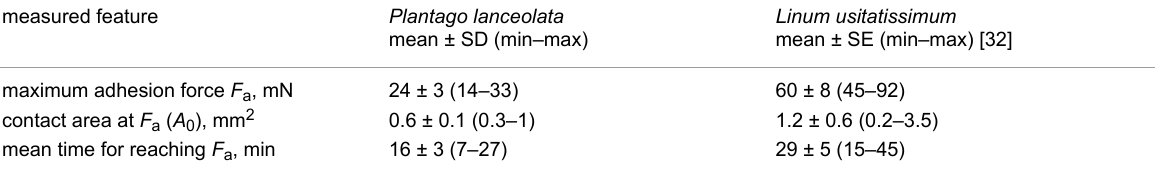
Table 3: Comparison of adhesion force data for Plantago lanceolata (cellulose mucilage) and Linum usitatissimum (pectic mucilage). measured